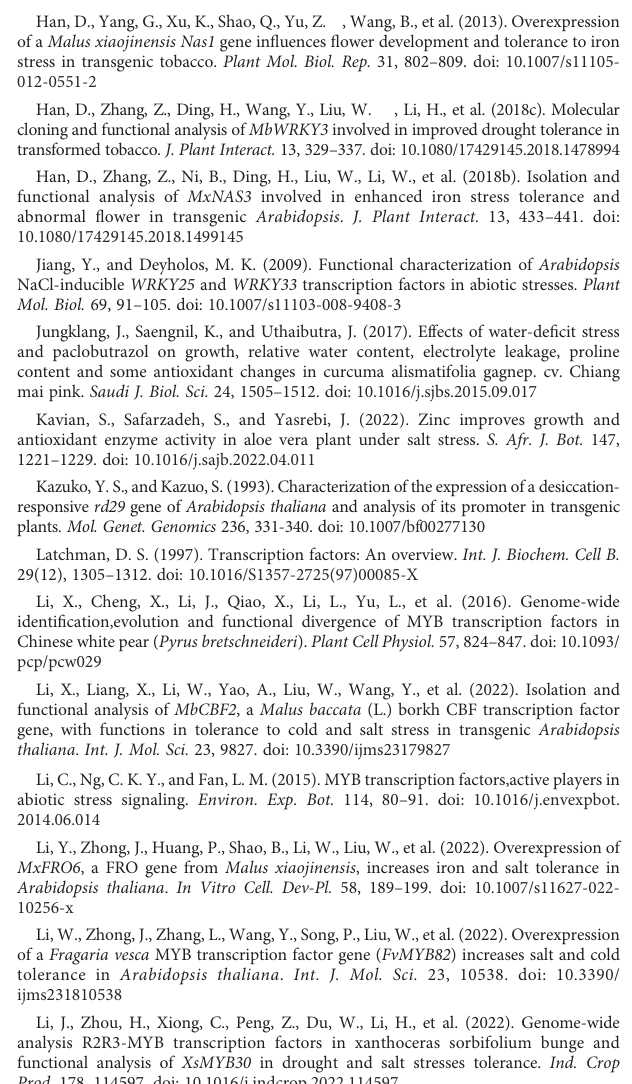
SUPPLEMENTARY FIGURE 1 Gene sequence and amino acid sequence of MbMYBC1. The underscore marked the conservative sequence of